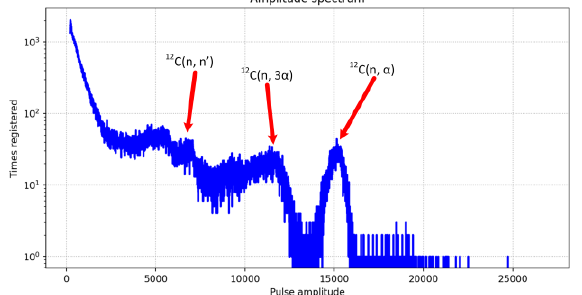
figure 4 . Peaks corresponding to aforementioned nuclear reactions are prominent.